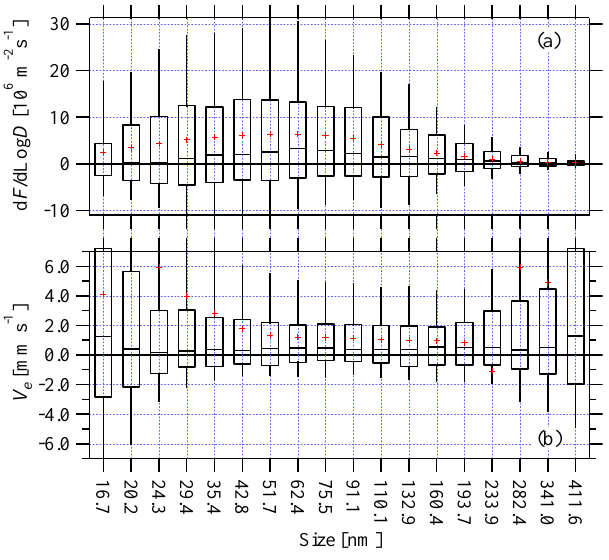
Figure 4. Percentiles (10, 25, 50, 75, and 90%) and averages (+) of fluxes (a) and exchange 2 Fig. 4. Percentiles (10, 25, 50, 75, and 90%) and averages (+) of velocities (b) by bin midpoint size ( D ). 3 fluxes (a) and exchange velocities (b) by bin midpoint size ( D) .